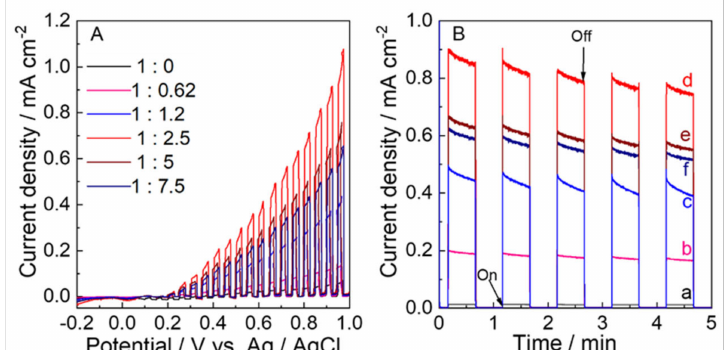
Figure 9. ( A ) Linear sweep voltammograms (LSV), and ( B ) Time course of the photocurrent at 0.68 V vs. Ag/AgCl (1.23 V vs. RHE) of the (a) WO 3 − 0, (b) WO 3 − 0.62, (c) WO 3 − 1.2, (d) WO 3 − 2.5, (e) WO 3 − 5, and (f) WO 3 − 7.5 electrodes with visible-light irradiation chopped in a 0.1 M phosphate buffer solution of pH 6.0 with visible-light irradiation ( λ > 450 nm, 100 mW cm − 2